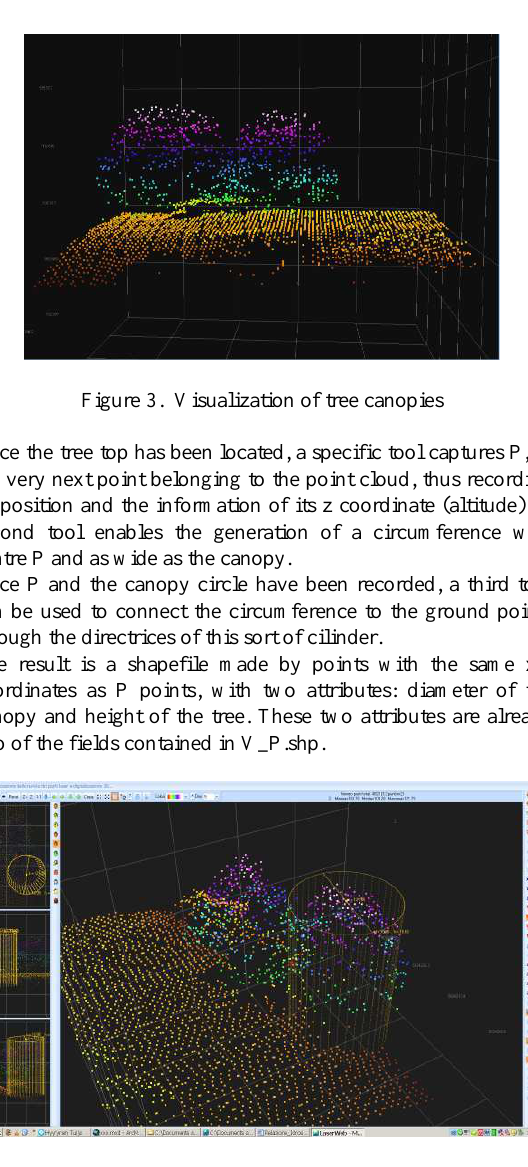
Figure 4. Detection of the tree top centre and canopy